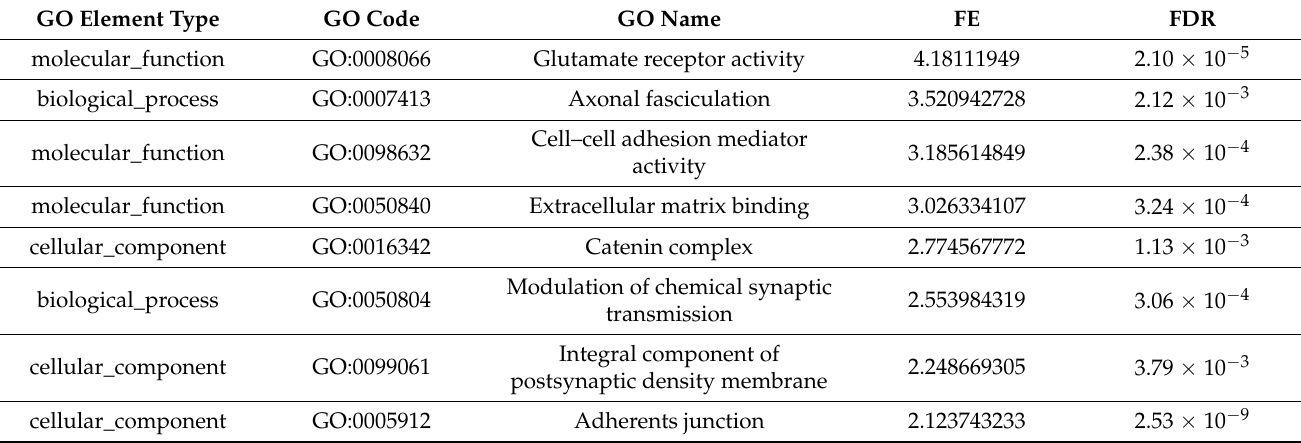
Table 7. Enrichment Analysis for Cluster